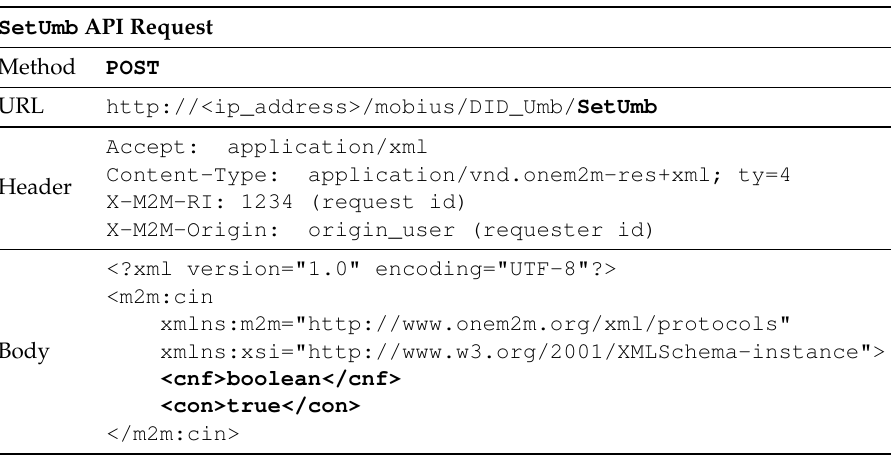
Table 5. An example of the SetUmb API request to turn the umbrella light